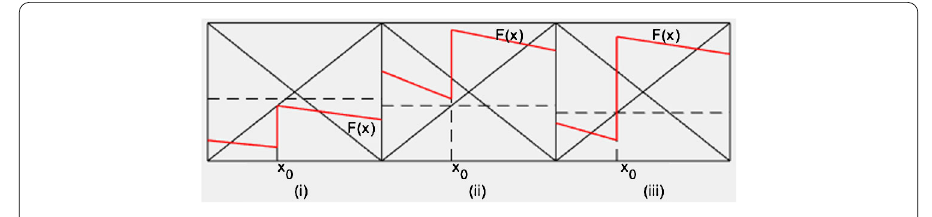
Figure 4 Three cases in Theorem